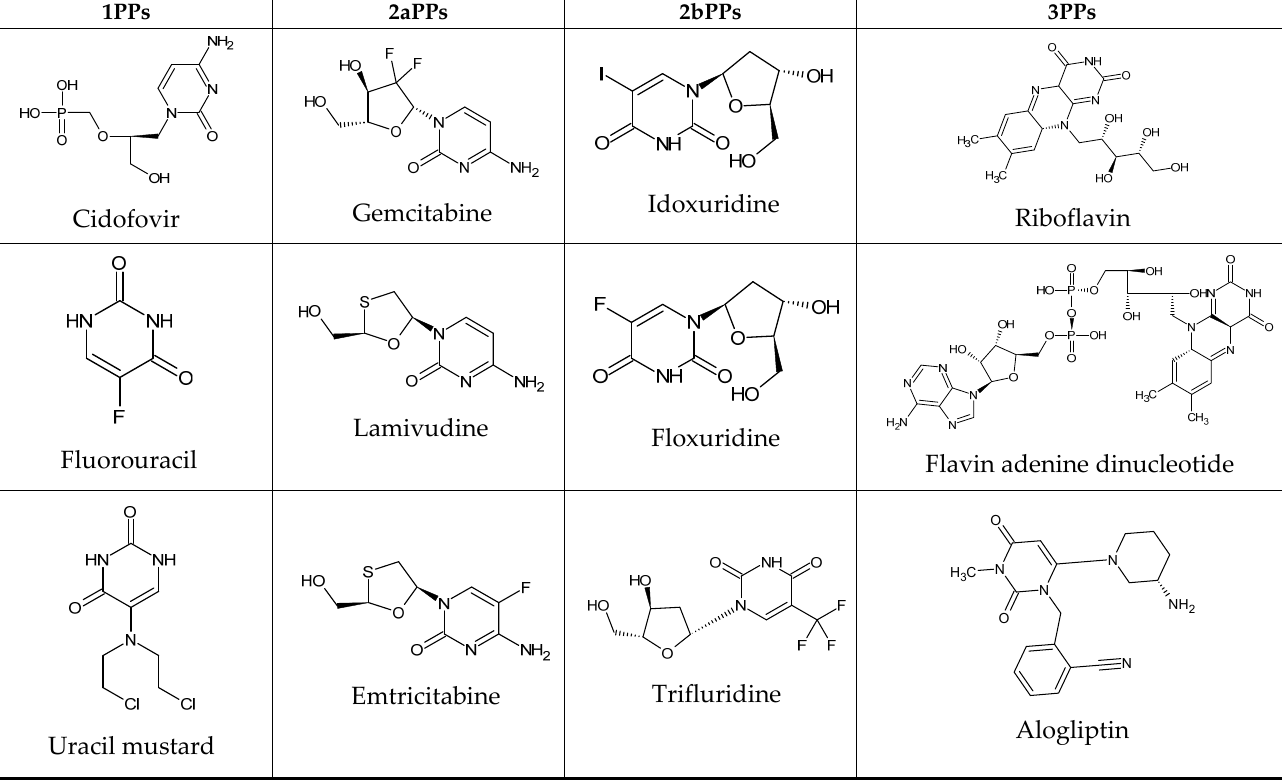
Table 1. Structures of pyrimidonic pharmaceuticals and their classification according to the number of rings. 1PPs